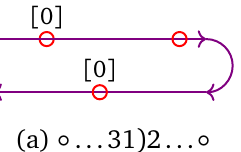
Figure 7: Three operators in wing configurations of spread 0.